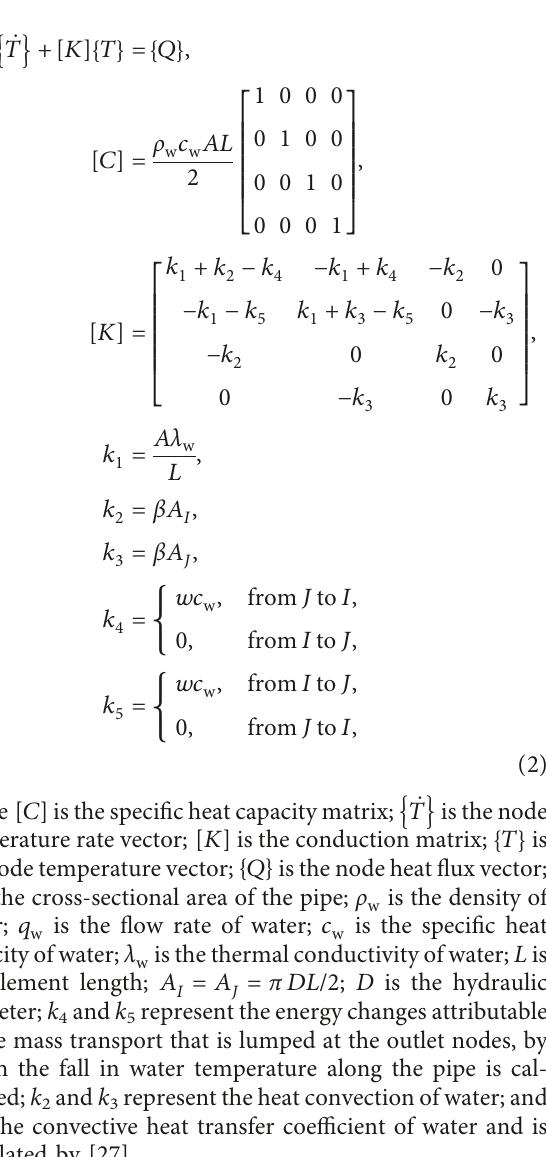
Figure 1: Heat exchange of the coupled thermal-fluid